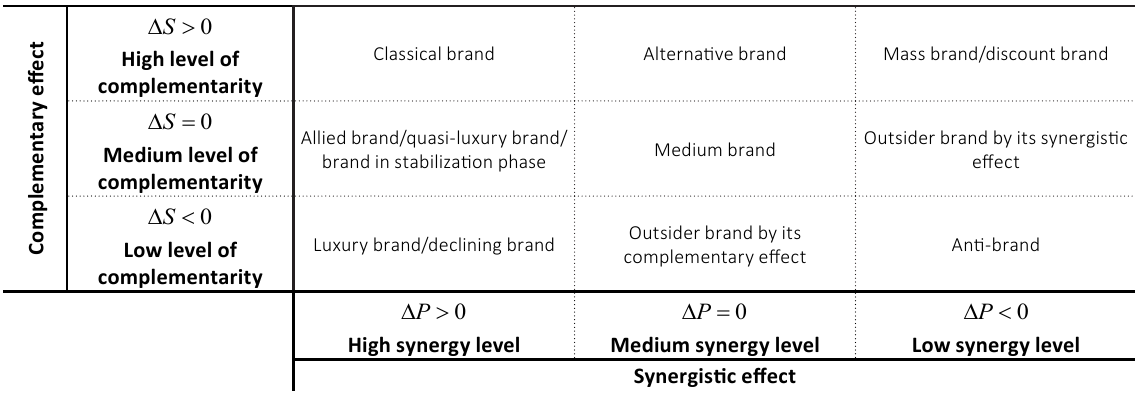
Table 8. Portfolio role-based brand classification matrix by manifestations of the complementary and synergistic